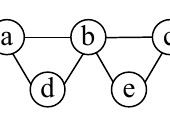
Figure 3. An example for maximal independent set (MIS)